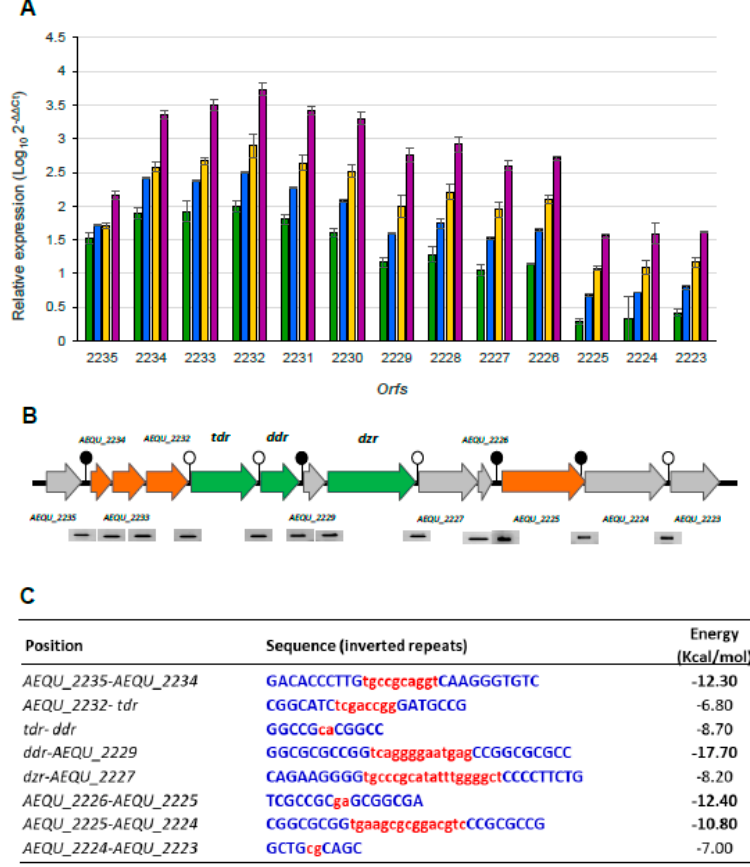
Figure 4. Quantification of the effect of daidzein on the expression of genes involved in the equol biosynthesis gene cluster of A. equolifaciens DSM19450 T by RT-qPCR ( A ). The graph shows the relative expression of the genes in the presence of 50 (green), 100 (blue), 150 (yellow) and 200 (purple) of daidzein in relation to gene expression of the reference condition (without daidzein) and after normalization with the expression of the elongation factor Tu housekeeping gene. Gene organization and transcriptional analysis by RT-PCR of the intergenic regions of the equol biosynthesis cluster of A. equolifaciens ( B ). Summary of the inverted repeat sequences resembling ρ -independent terminators and their respective free energy (kcal / mol) ( C ). Terminators with the lowest (in bold) and highest free energy are indicated by filled and unfilled circles, respectively, in Panel